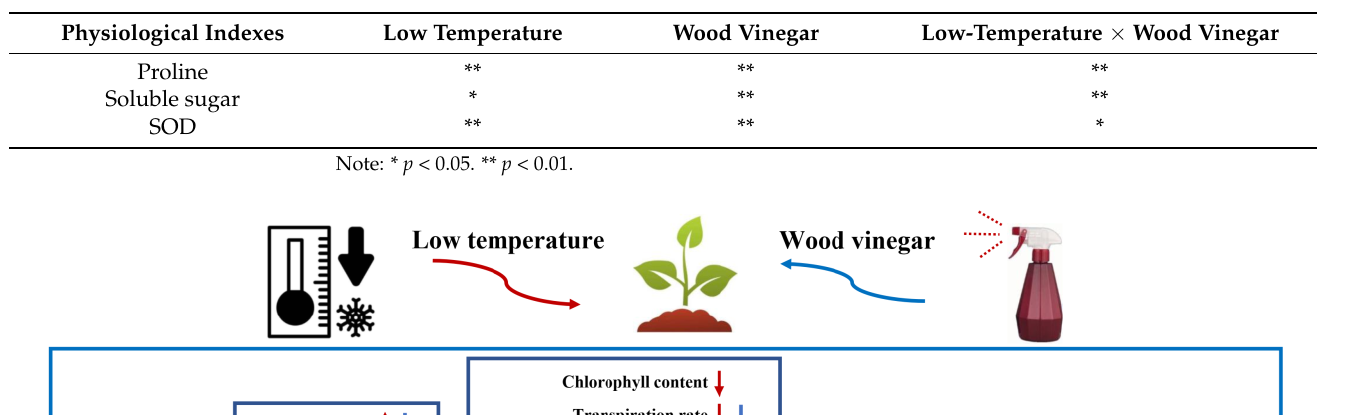
Table 3. Variance analysis of the influence of low temperature and wood vinegar treatment and their interaction on the physiological indexes of rapeseed.